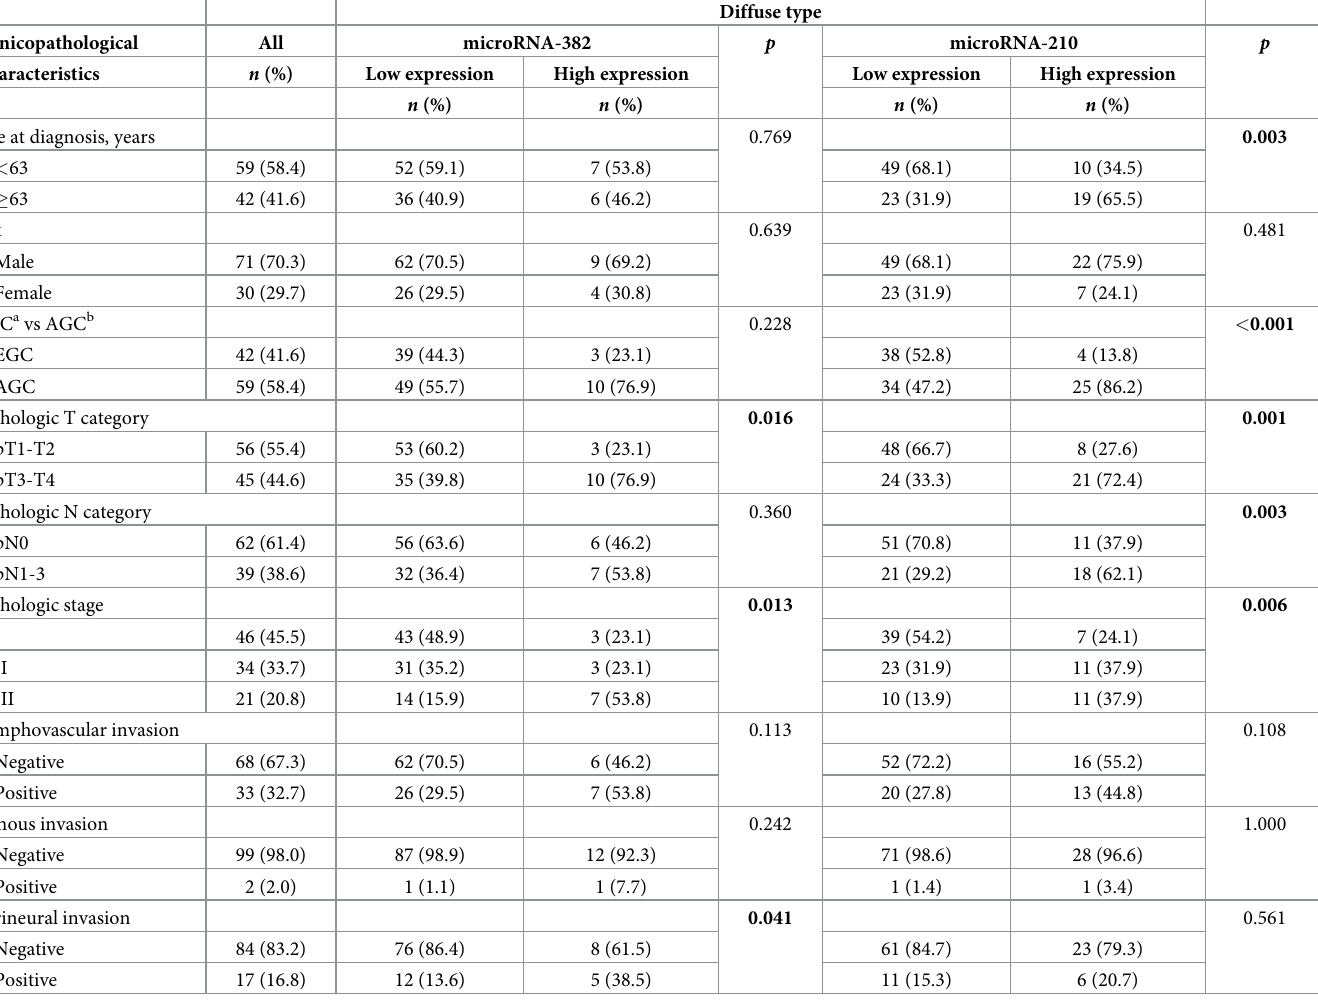
Table 4. Relationship between clinicopathologic characteristics of tumor and expression levels of miR-382 and miR-210 in gastric adenocarcinoma with diffuse type of Lauren